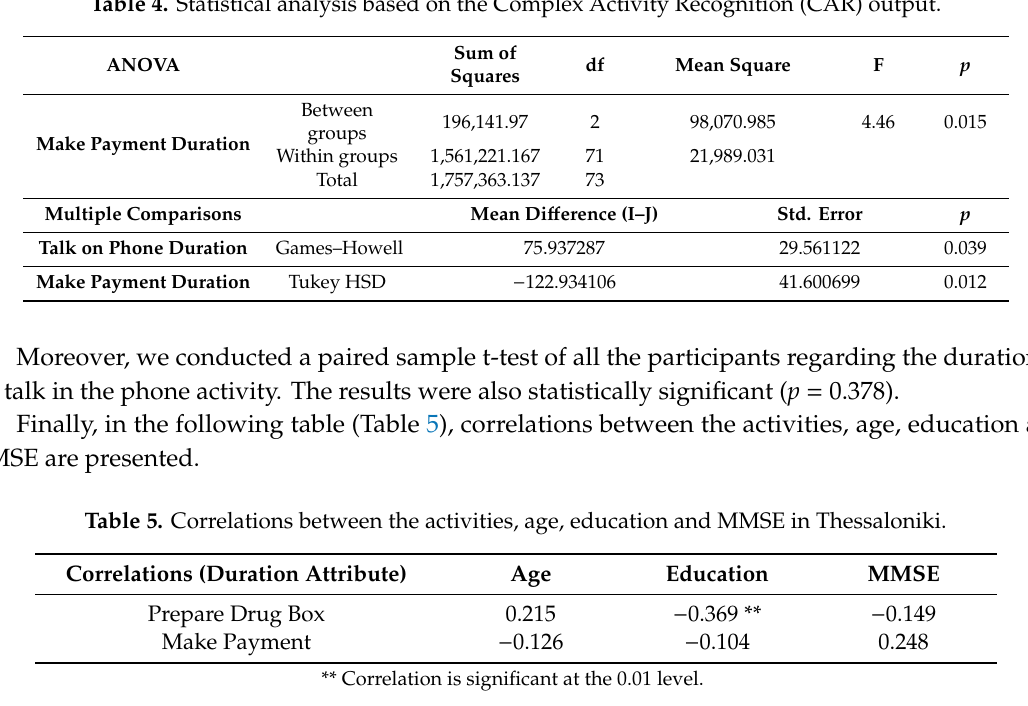
Table 4. Statistical analysis based on the Complex Activity Recognition (CAR) output.